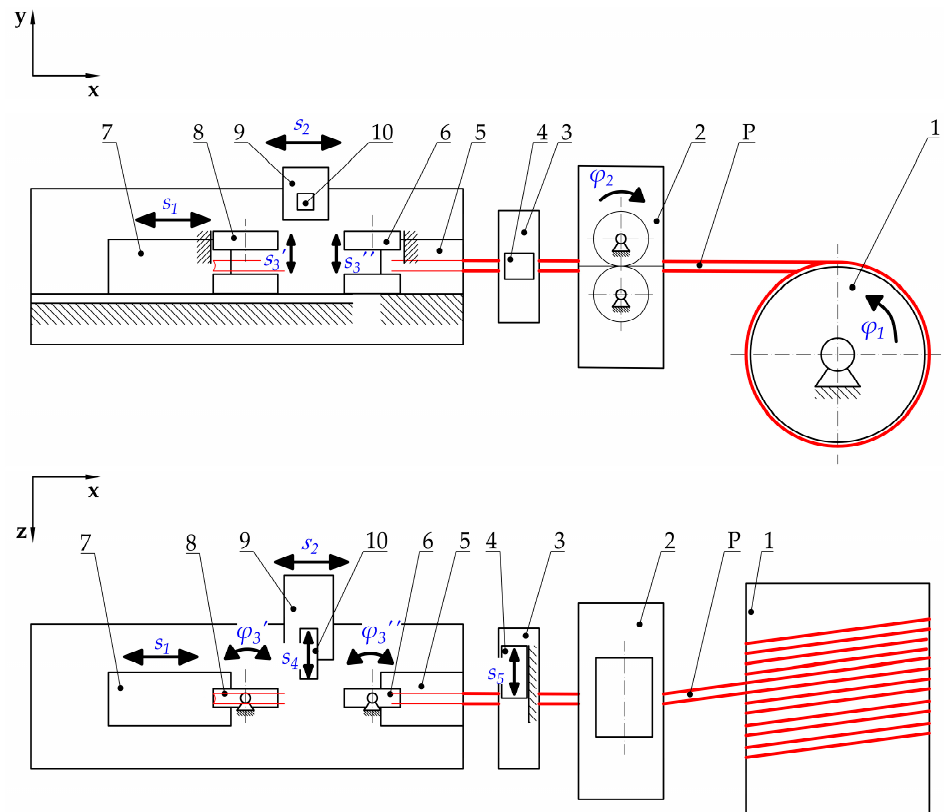
Figure 3. The concept of the automatic hot plate welder: P—belt, 1—spool with wound belt, 2—roller feeder, 3—cutting unit, 4—knife cutting system, 5—fixed belt holder, 6—jaw of fixed belt holder, 7—movable belt holder, 8—jaw of movable belt holder, 9—heating unit, 10—hot plate; s 1 …s 5 —linear displacement, φ 1 … φ 3 —angular displacement.